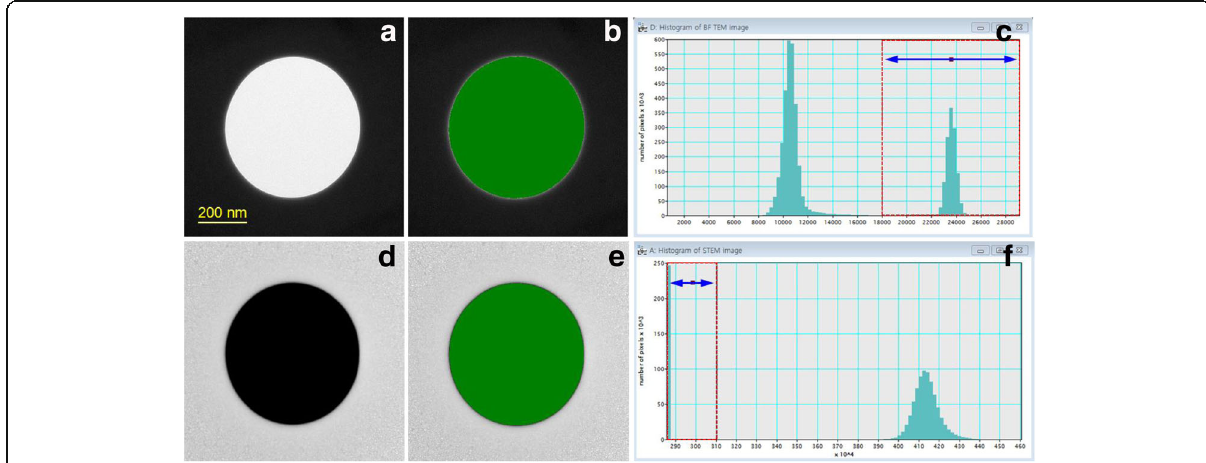
Fig. 4 The determination of projected area. a The BF-TEM image. b The selected hole area. c The corresponding TEM histogram. d The HAADF- STEM image. e The selected hole area. f The corresponding STEM histogram. b – c The selected hole area was highlighted in green color